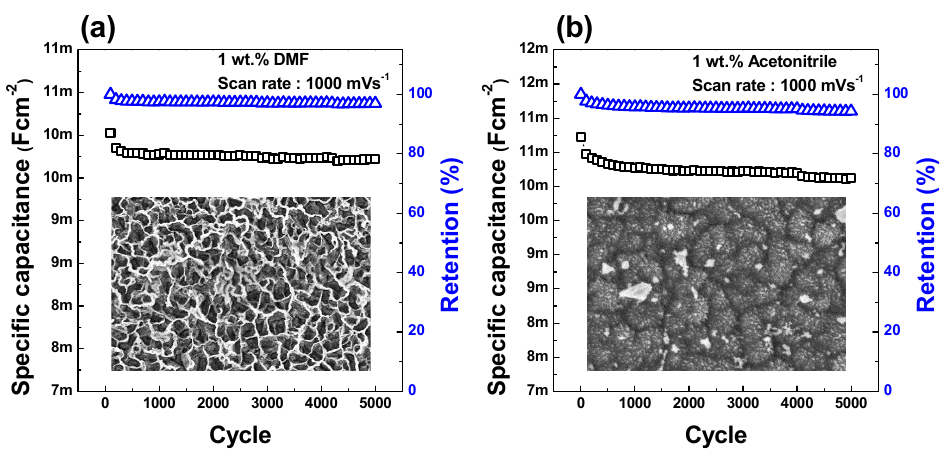
Figure 7. Life cycle tests of the MoS 2 –CNW samples in 1 wt.% ( a ) DMF and ( b ) acetonitrile for up to 5000 cycles and surface morphology change after life cycle test.